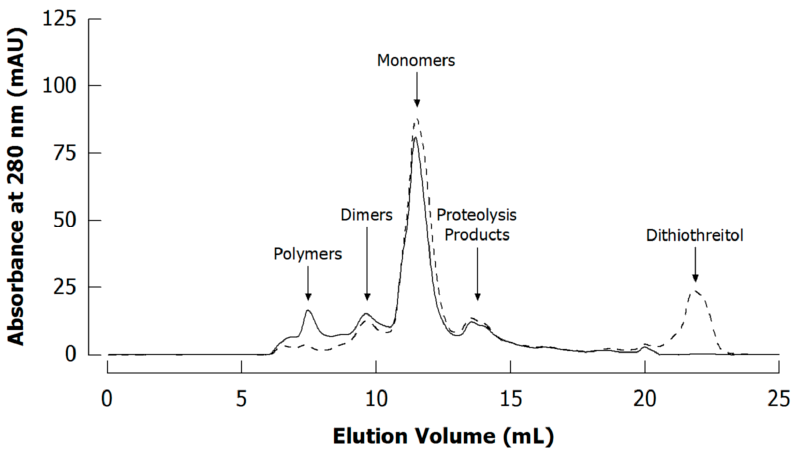
Figure 9. Typical size exclusion chromatograms (Superdex 200 column) of unreduced (without dithiothreitol; full line) and reduced (with dithiothreitol; dashed line) casein in phosphate buffer prior to cross-linking experiments (see Appendix A1 and A4 for experimental details).